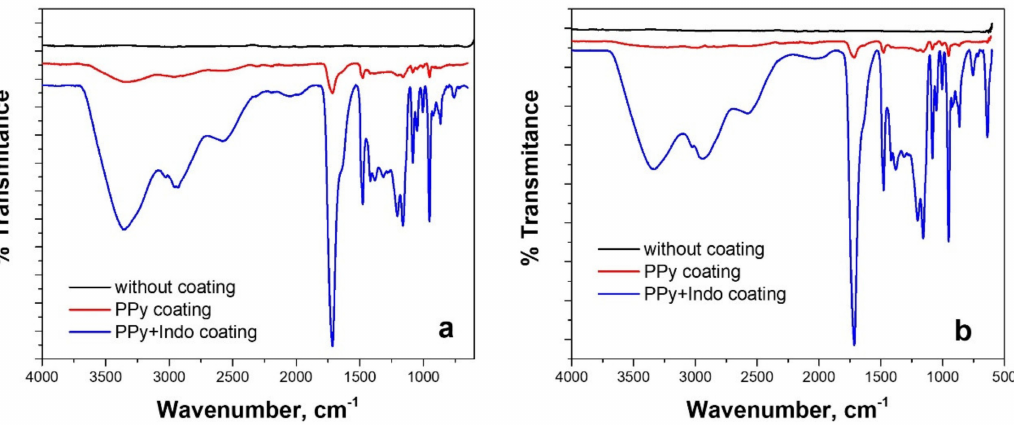
Figure 5. FTIR spectra of electrochemically synthesized PPy and PPy-Indo coatings on WBC ( a ) and Hera ( b ) CoCr-based alloy substrates from ionic liquid-based electrolyte.